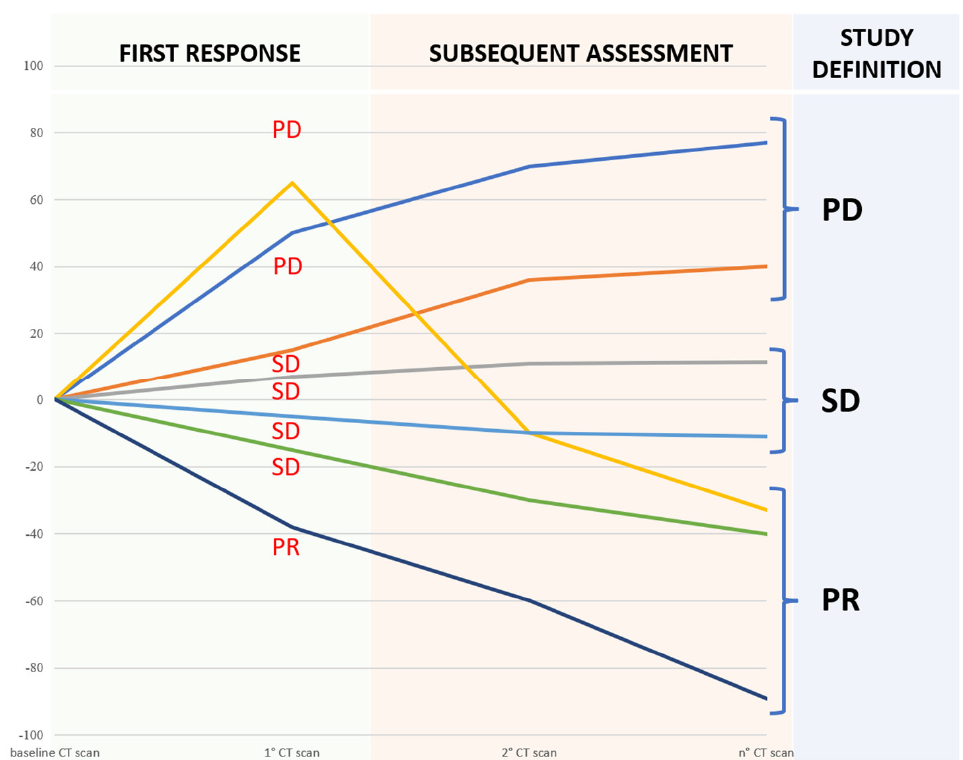
Figure 2. The best response known during subsequent assessment was adopted to define the actual response and understand the potential predictive role of delta-radiomics.